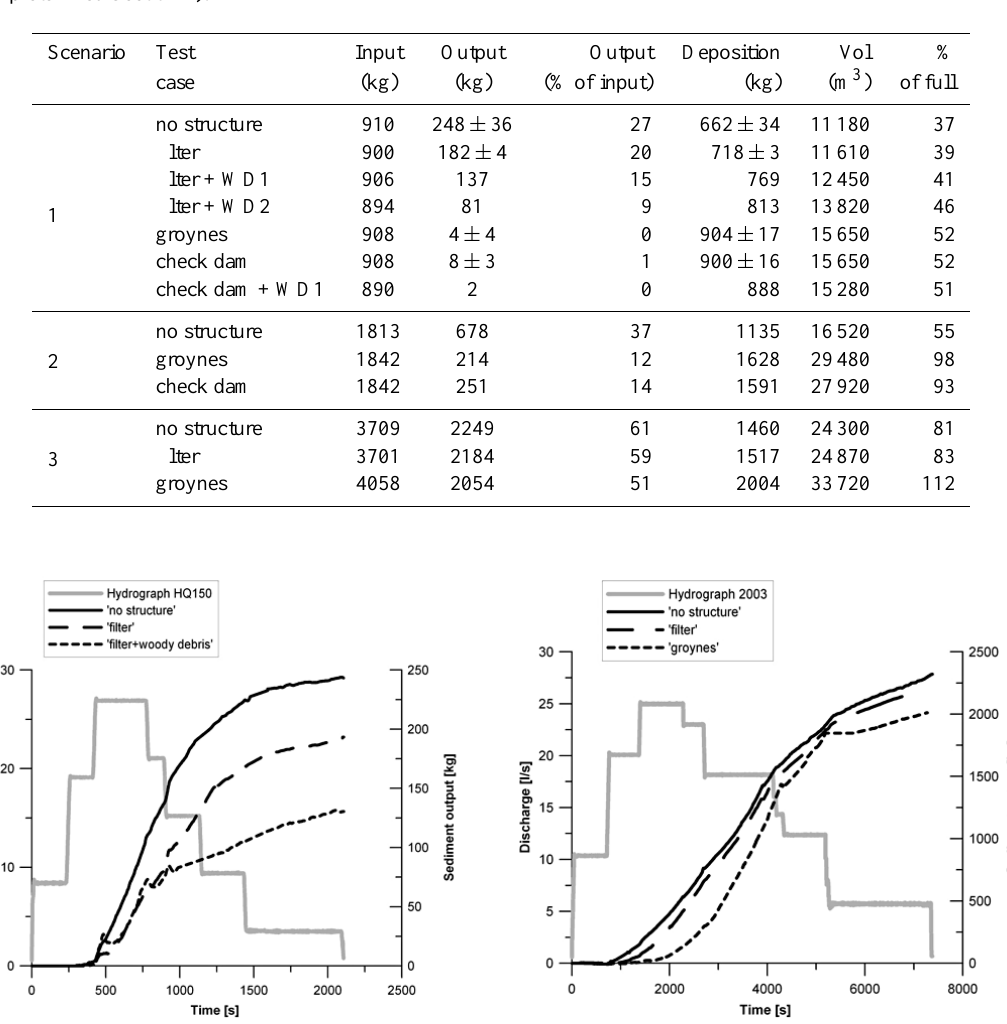
Table 2. Overview of results from all experiments (WD=woody debris; Vol=estimated deposited volume in nature, “full” refers to the volume of complete filled Section 1).